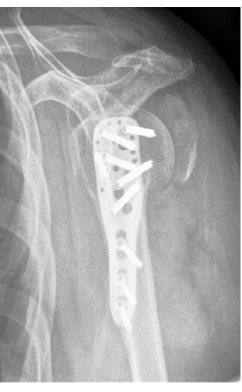
Figure 11. Complication Type 2b. Y-view radiograph of the left shoulder after angular stable plate osteosynthesis illustrates displacement of the greater tuberosity.